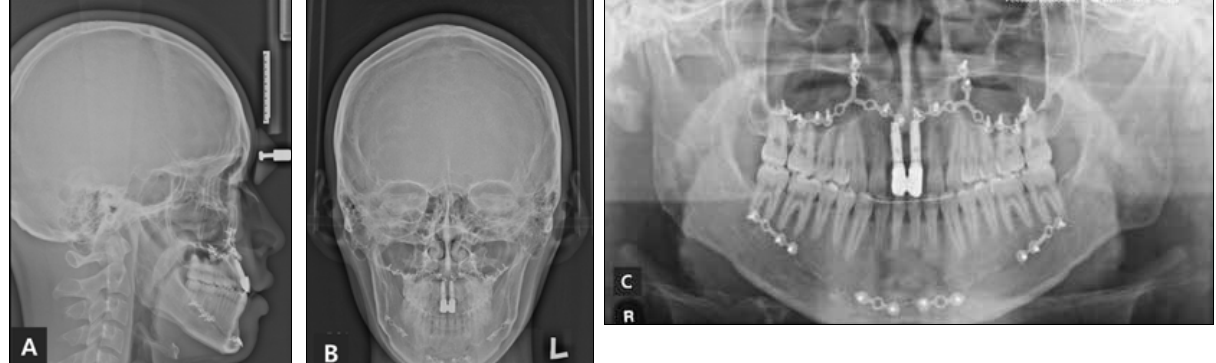
Figure 7. One-year post-treatment radiographs. A, lateral cephalogram; B, posterio-anterior cephalogram; C, panoramic